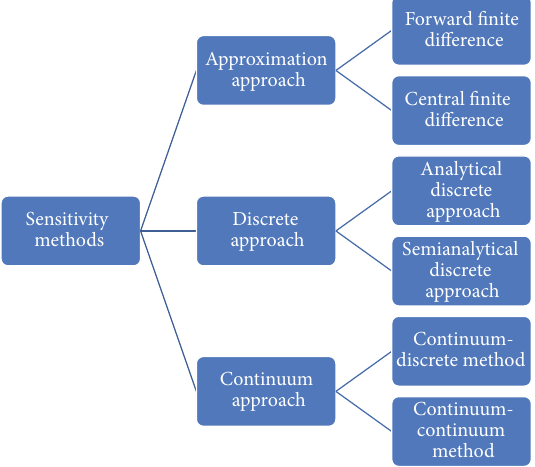
Figure 3: Different approaches to sensitivity